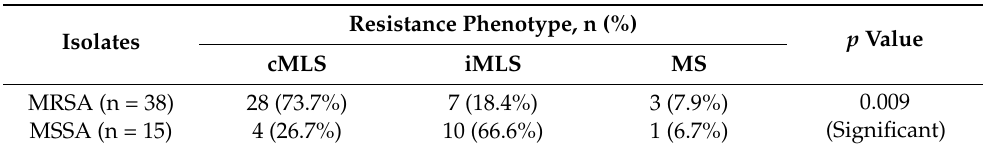
Table 3. Correlation between the methicillin-resistance and the type of MAC-resistance phenotype S. aureus isolates.